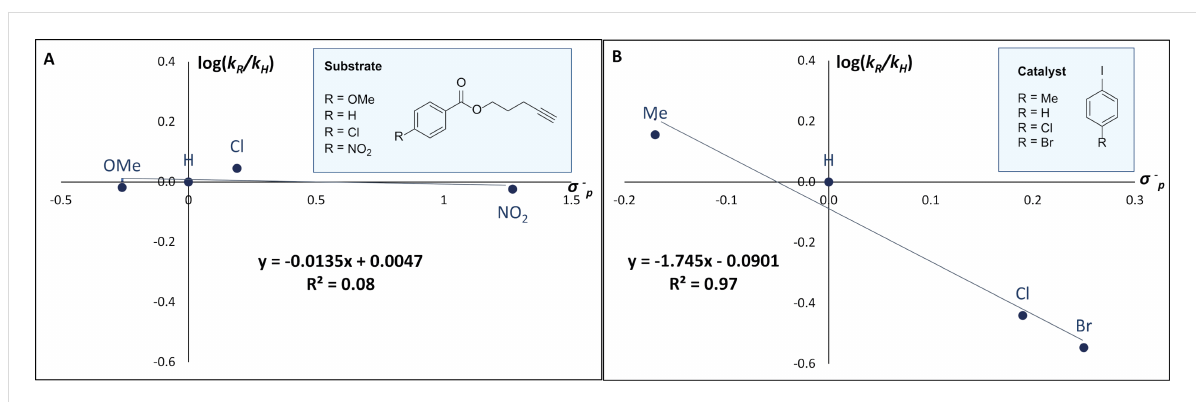
Figure 4: (A) Hammett plot varying the para -substitution on the alkyne ( ρ ≈ 0). (B) Hammett plot varying the para -substitution on the catalyst ( ρ <